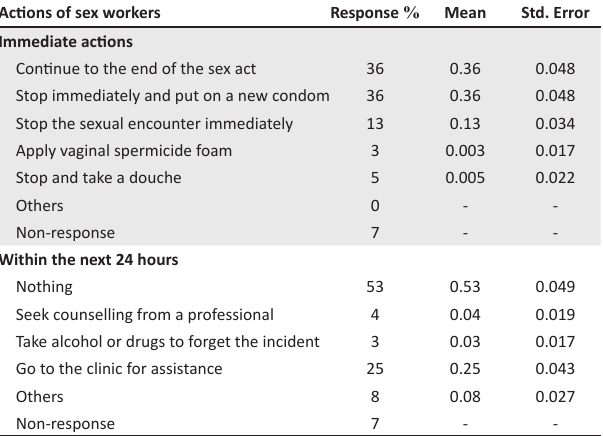
TABLE 2: Actions of female sex workers faced with condom failure during penetrative sexual encounters with clients in Cape Town. Actions of sex workers Response % Mean Std.